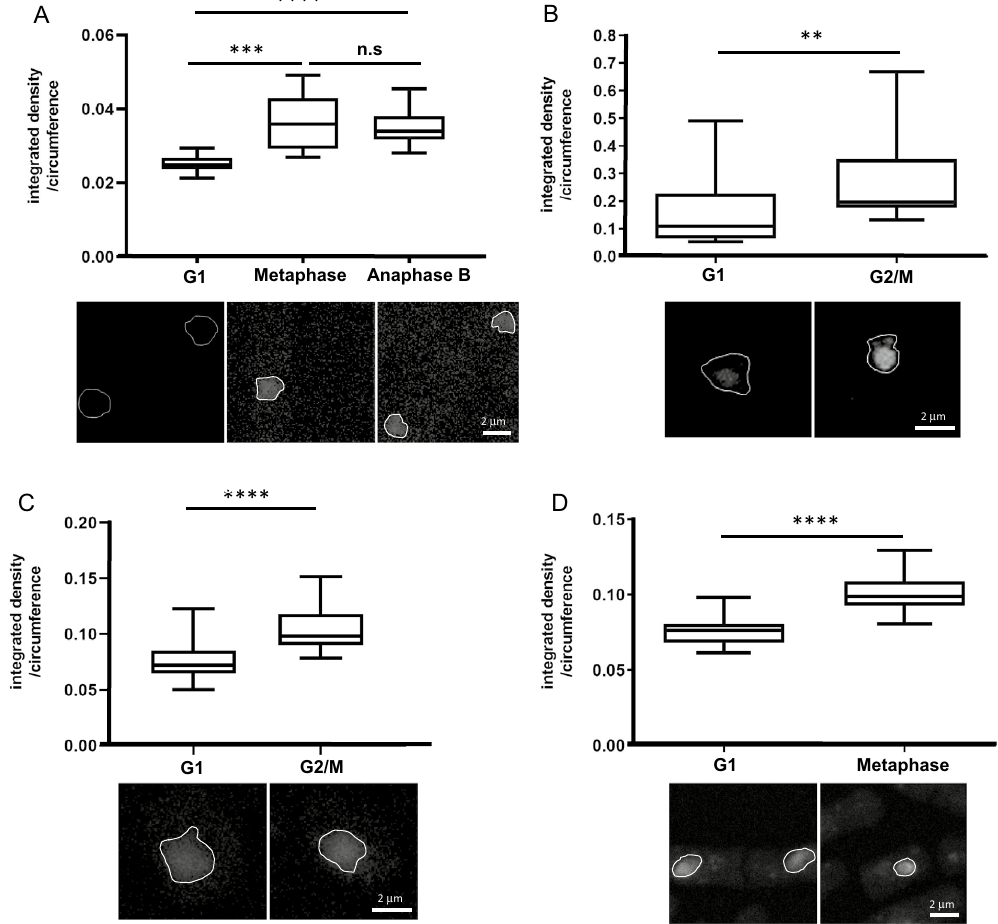
Figure 1. Measurement of chromosome compaction in live and fixed yeast. ( A ) Cells were grown to mid-log phase and analyzed via two-photon microscopy. Cells in G1/S, metaphase, and anaphase B were selected for live-cell analysis based on morphology and localization of the Cdc11-GFP (as shown in Supplementary Figure S1). 20 nuclei from each cell cycle phase were analyzed. **** p < 0.0001. n.s.—not significant. ( B ) S. cerevisiae cells were grown to mid-log phase and stained with Hoechst33342. The cell cycle phase was determined by cell morphology. Chromatin was analyzed via two-photon microscopy. 28 nuclei were analyzed from each cell cycle phase. ** p < 0.001. ( C ) S. cerevisiae cells were grown to mid-log phase, fixed, and stained with DAPI. The cell cycle phase was determined by cell morphology. Chromatin was analyzed via two-photon microscopy. 25 nuclei were analyzed from each cell cycle phase. **** p < 0.0001. ( D ) S. pombe cells were grown to mid-log phase, fixed, and stained with DAPI. The cell cycle phase was determined by cell morphology. Chromatin was analyzed via two-photon microscopy. 27 nuclei were analyzed from each cell cycle phase. **** p <